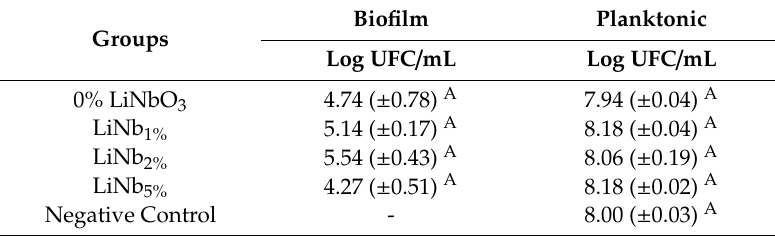
Table 4. Antibacterial activity through biofilm and planktonic analyses of the formulated adhesives.